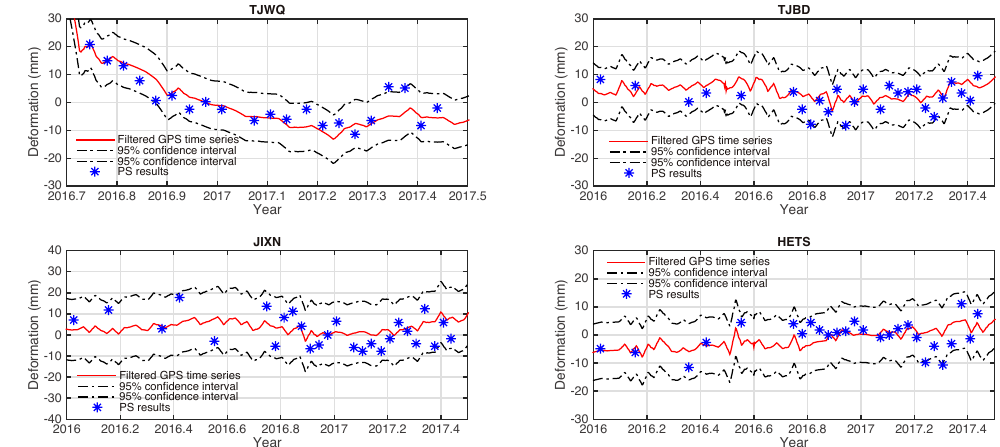
Figure 10. Comparison between GPS time series and Sentinel-1A derived LOS deformation time series. The velocities of the GPS sites were projected in the LOS direction. The red line represents the filtered time series of GPS stations, black dotted line represent the 95% confidence interval, and the asterisk represents the InSAR-derived time series for the corresponding PS